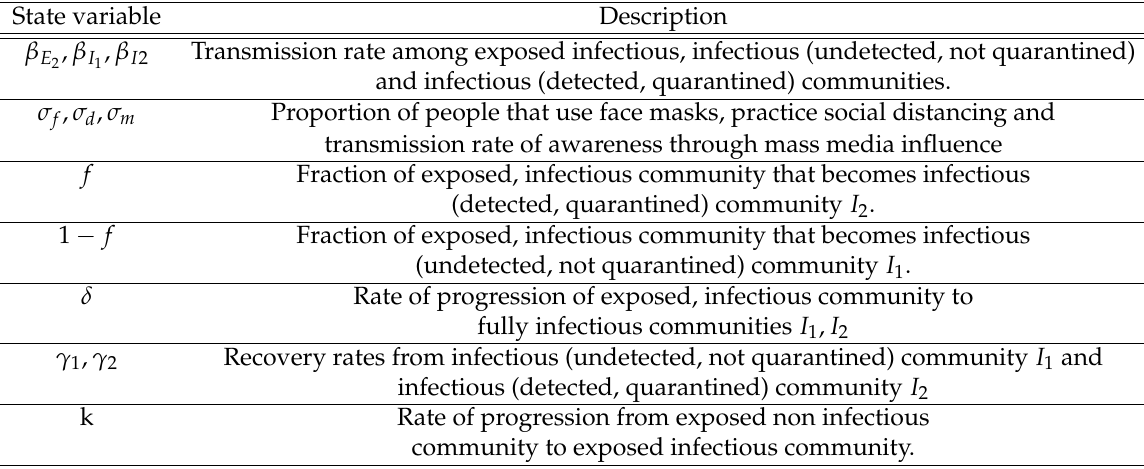
Table 2. Parameters used in (3) and their